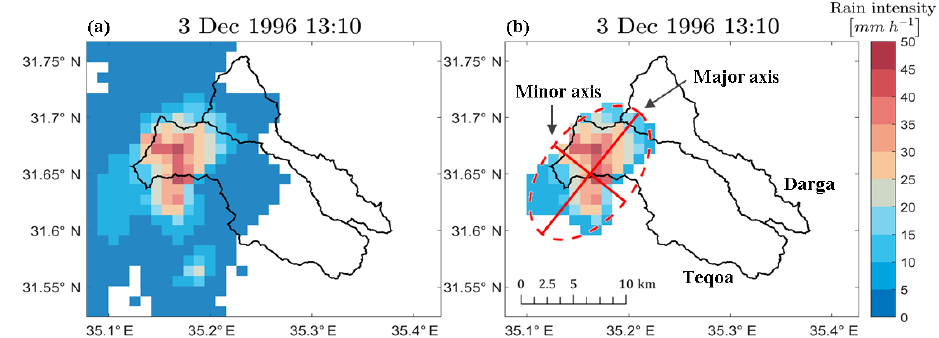
Figure 2. An example of a rain-cell derivation for 3 December 1996, 13:10 (UTC) over the Darga and Teqoa catchments. Radar rainfall for the examined time (a) , a segment of an identified rain cell and its fitted ellipse (b) . The spatial properties of the presented cell are the following: area, 90km 2 ; orientation, 51 ◦ ; major axis length, 15km; minor axis length, 9km; ellipticity, 0.58; max rainfall intensity, 47mmh − 1 ; and mean rainfall intensity, 20mmh − 1